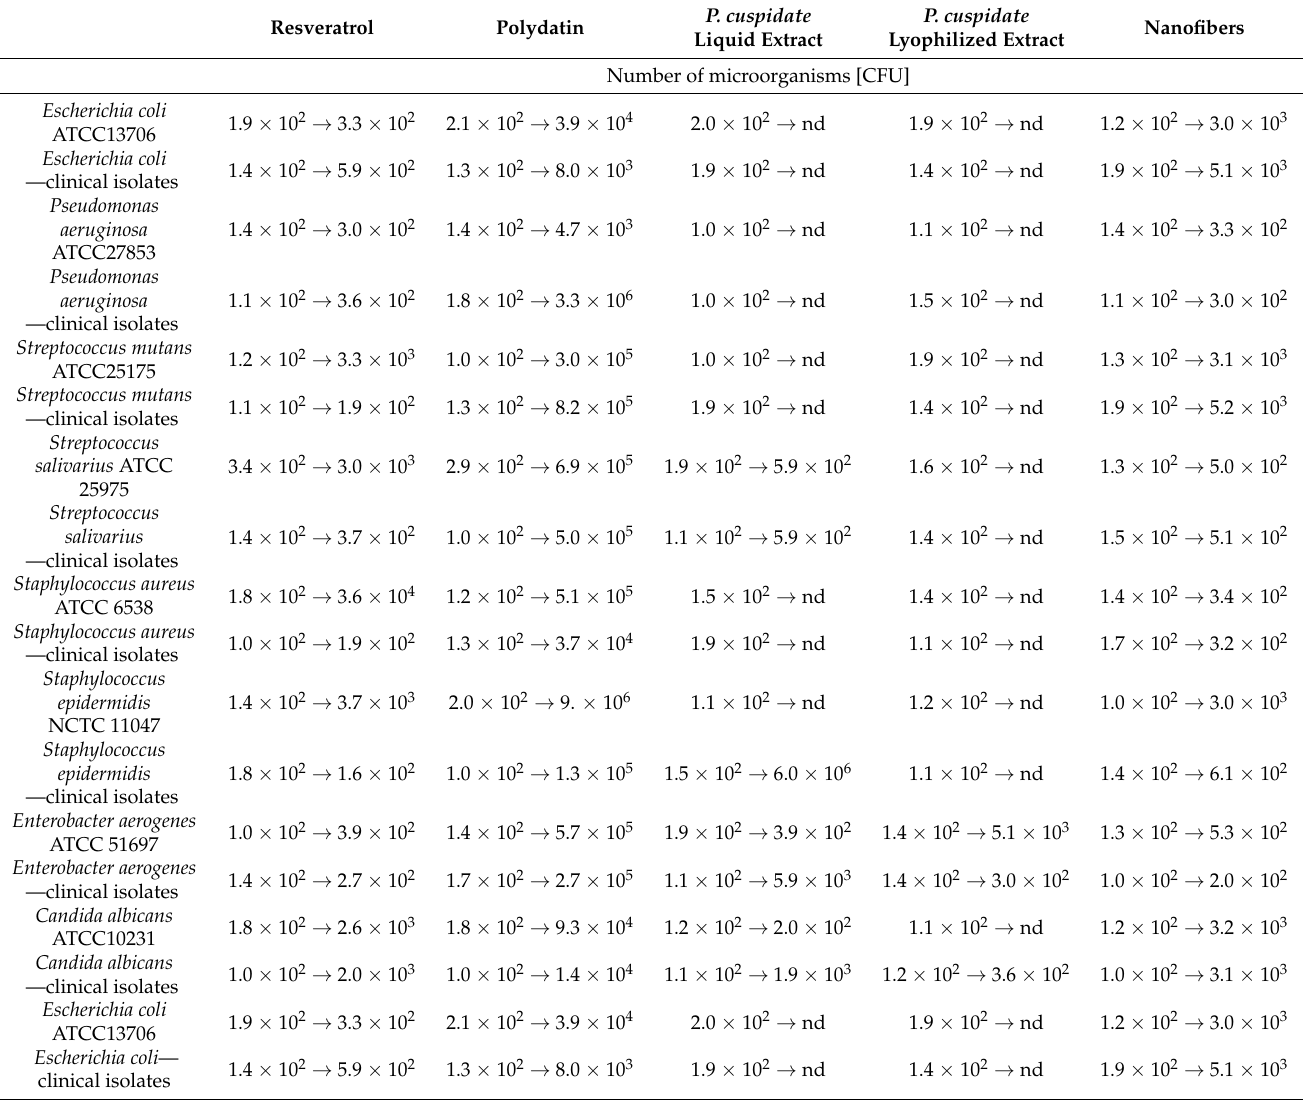
Table 1. Influence of the material (resveratrol, polydatin, Polygoni cuspidati extracts and nanofibers) on indicator microorganisms (reference strains and clinical isolates) by liquid culture method— concentration of the test sample = 100